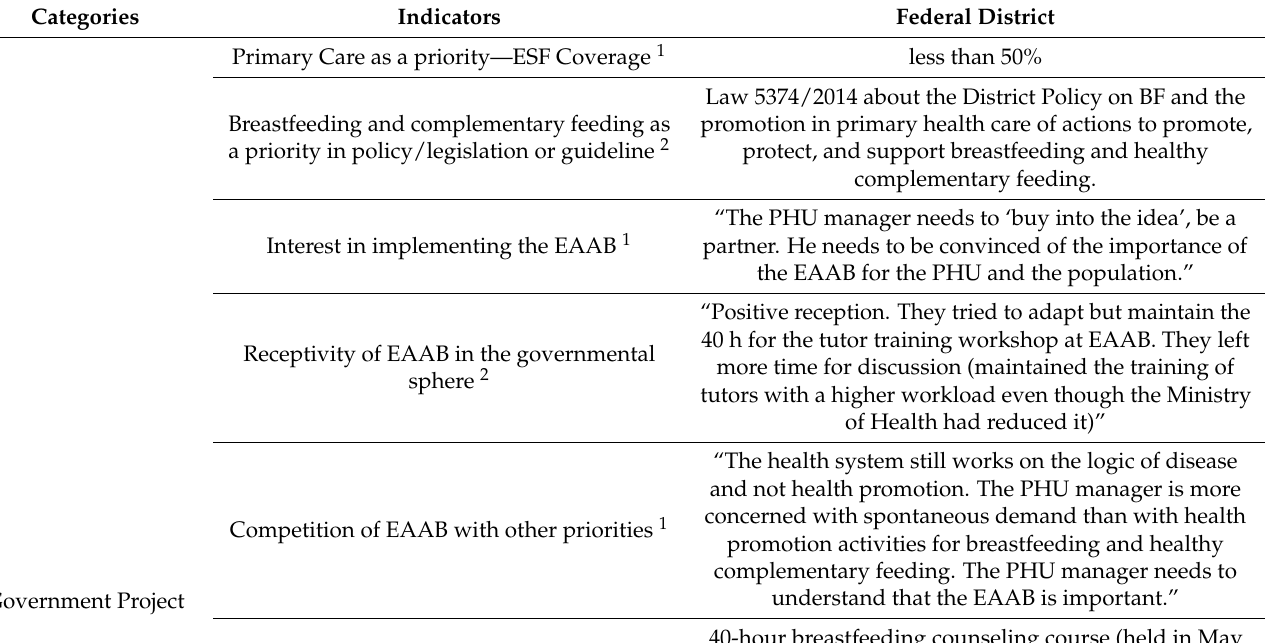
Table 2. Classification of indicators in the categories of Government Triangle, EAAB, Bras í lia, FD,